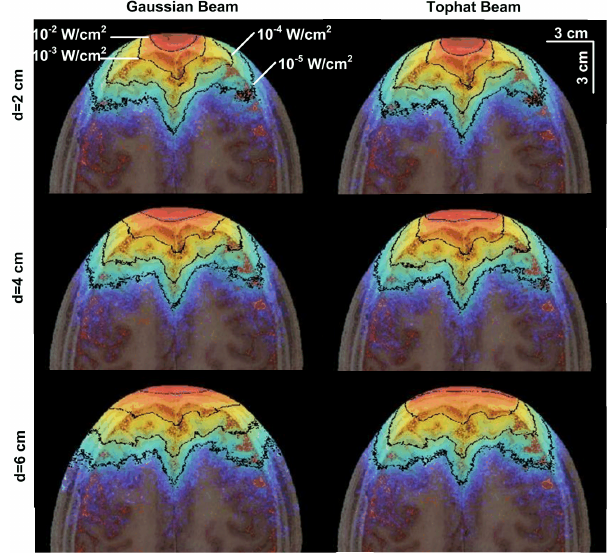
Fig. 3. The LLLT °uence distribution respective to Gaussian and Tophat (°at) beams at di®erent